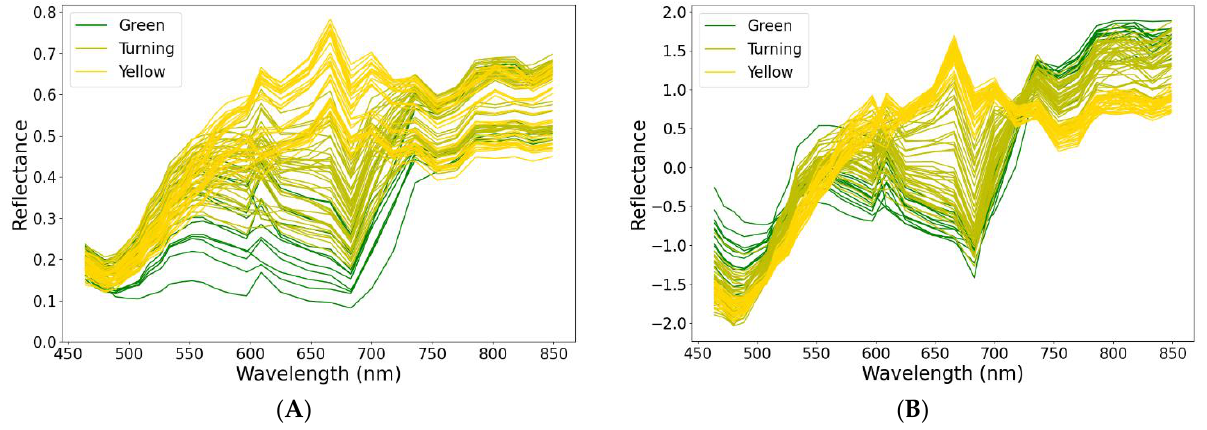
Figure 5. Reflectance spectrum of the oriental melons in ( A ) raw data and ( B ) pre-processed data with SNV.